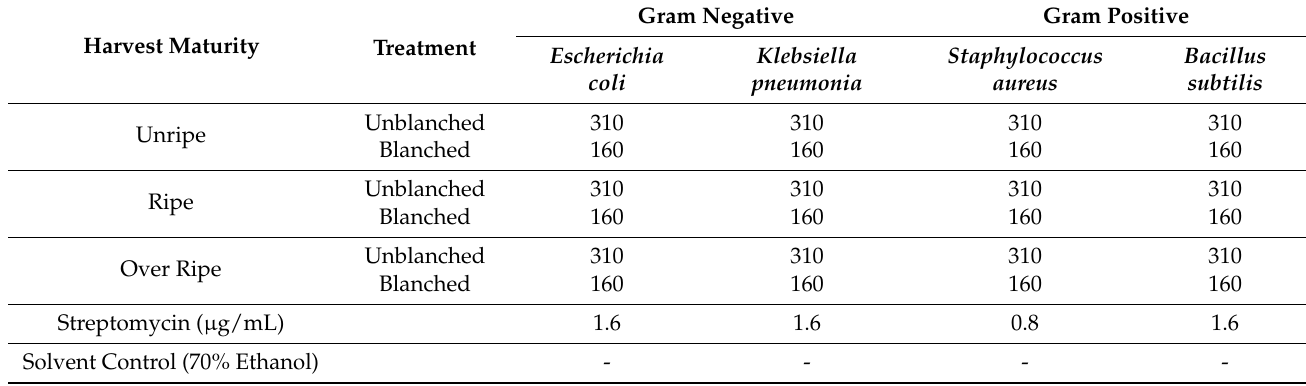
Table 3. Antibacterial activity (MIC, µ g/mL) of ethanol (70% ( v / v )) extracts from blanched (80 ◦ C, 3 min) ‘Wonderful’ pomegranate peel extracts at 3 different harvest maturities (unripe, ripe, and over